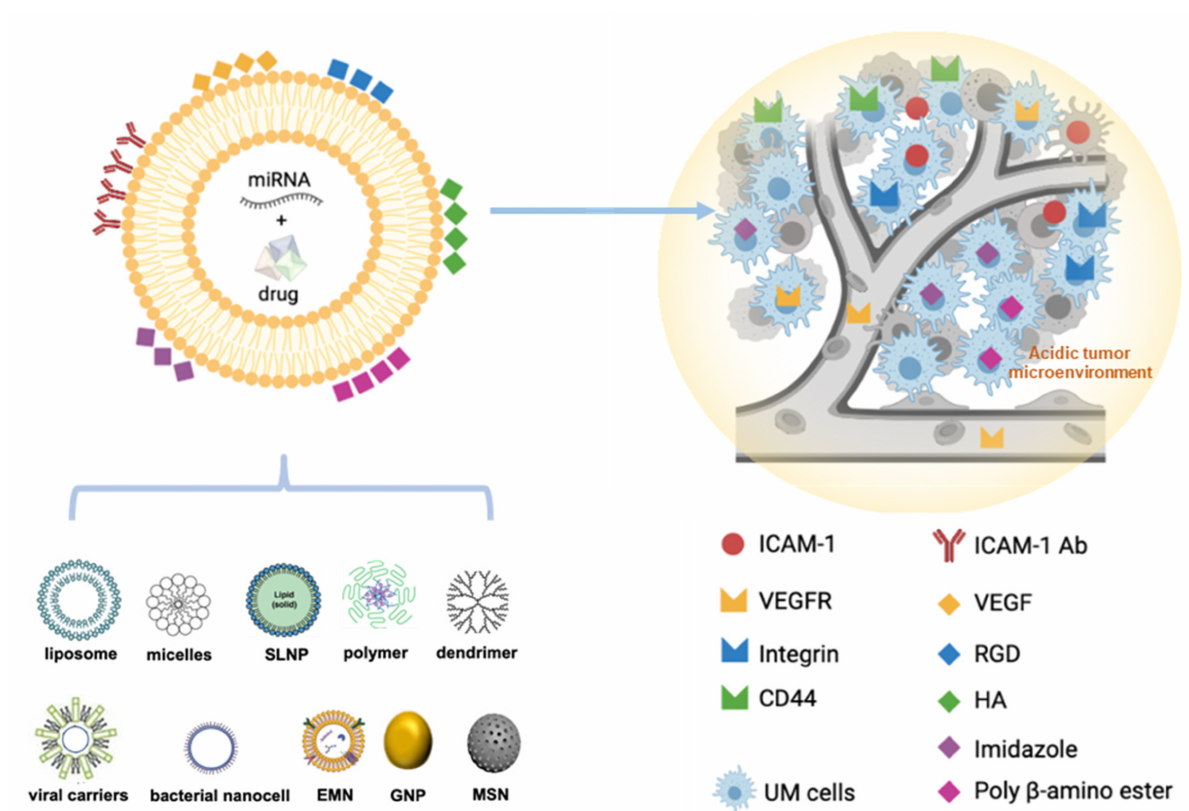
Figure 2. Schematic depiction of potential roles of NPs with surface modifications in UM